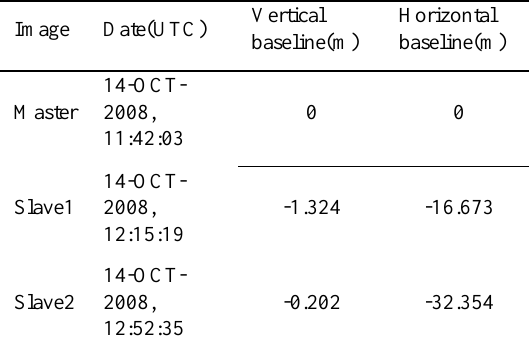
Table 1. Description of PolInSAR data